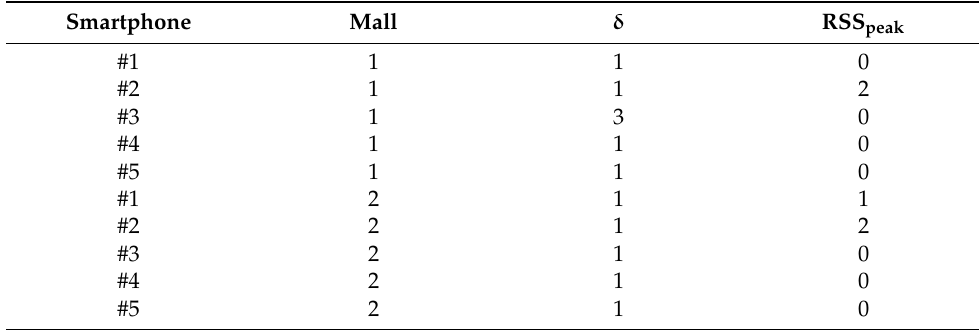
Table 5. δ and RSS peak optimal values for both malls and smartphones #1–#5.